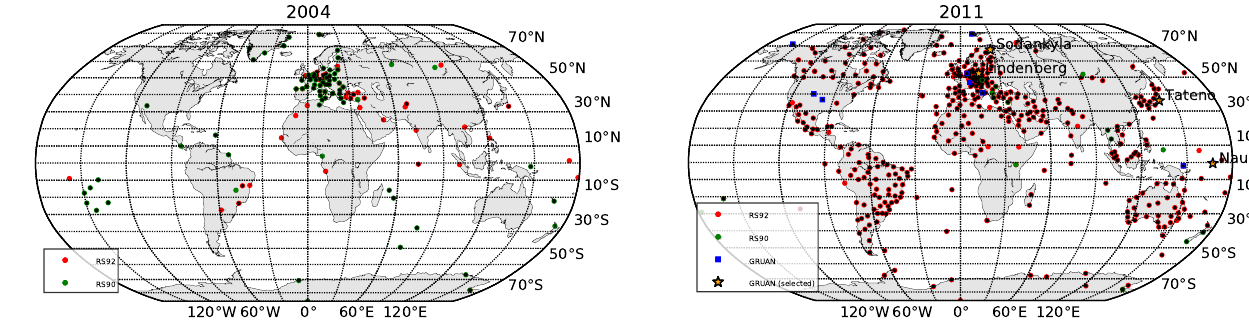
Figure 1. Map of geographic distribution of radiosonde launch sta- tions in 2004. Stations with launches of Vaisala RS90 are marked in green, those launching Vaisala RS92 in red. If there were collo- cations with GPSRO profiles at a station it is marked with a black dot.